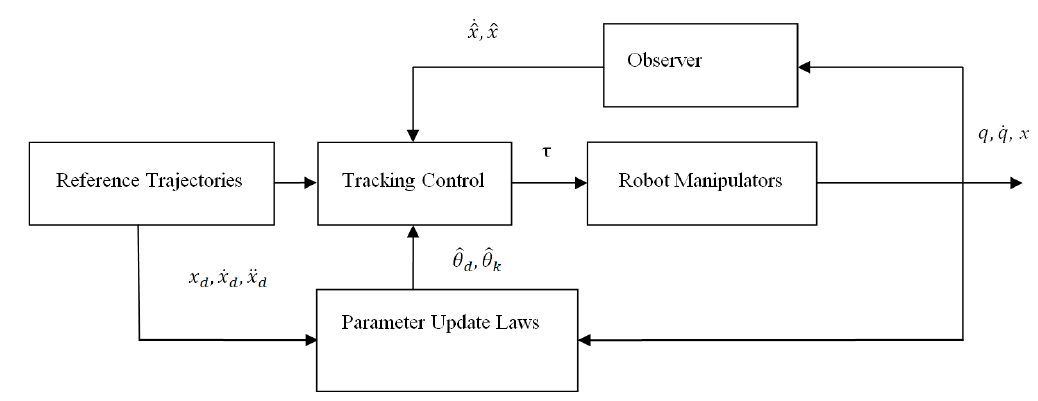
Figure 1. Adaptive tracking control scheme.